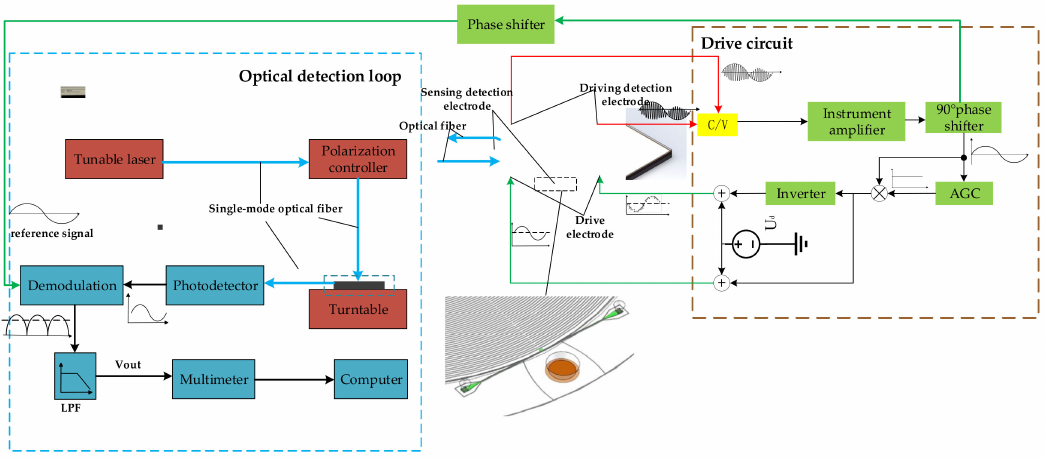
Figure 22. Experimental